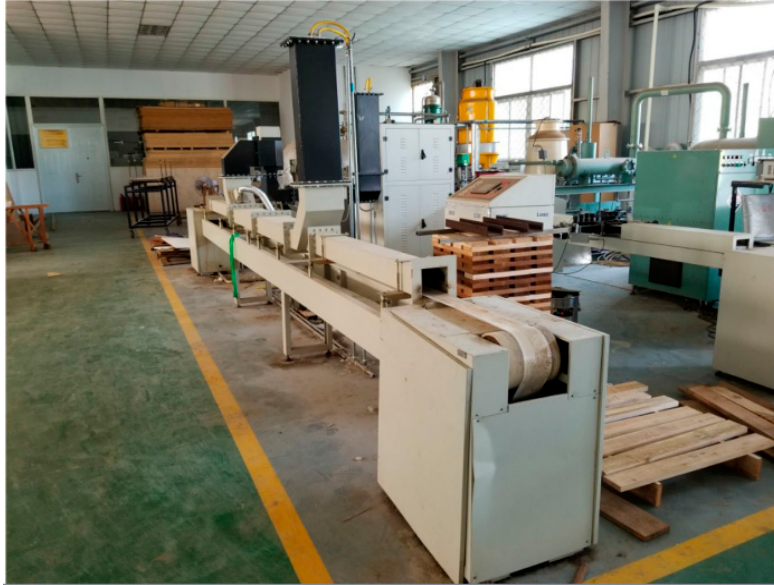
Figure 3. MW equipment used by [15]. Table 3. Summary of MOE and MOR changes for MW